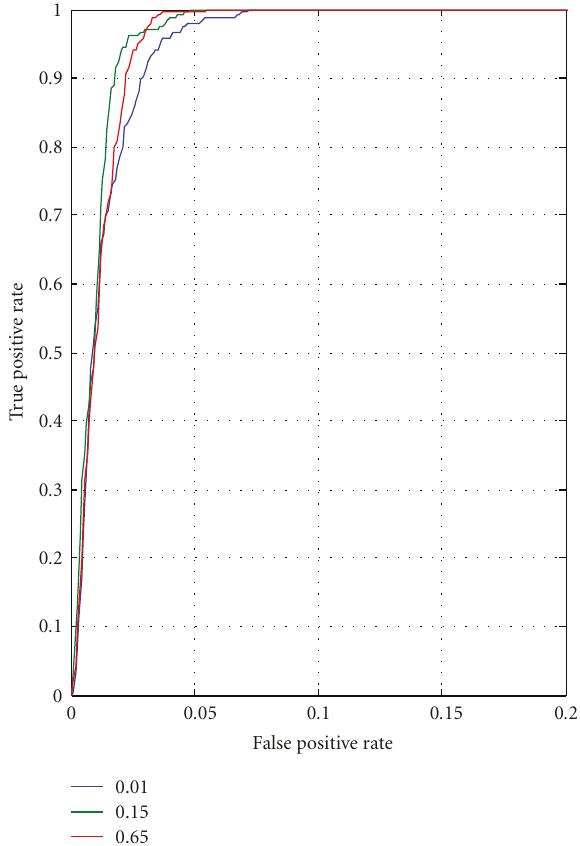
Figure 6: Rejection Criteria E ff ect: ROC curves for LAIRX statistic map thresholded at 0.01, 0.15, and 0.65,